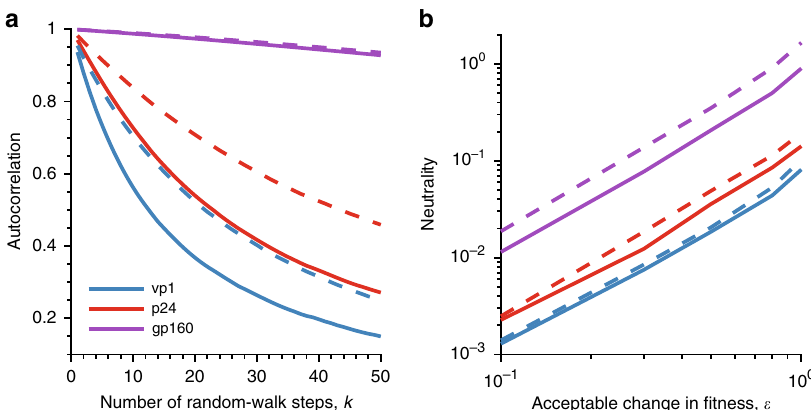
Fig. 7 Comparison of the fi tness landscapes reveals the constrained evolution of vp1 as compared to HIV proteins. a Comparison of the autocorrelation of sequence energies of each protein landscape (see the “ Methods ” section). The x -axis shows the number of random-walk steps ( k ) for which the autocorrelation was computed. Results are shown for two sets of starting sequences, which were selected within a Hamming distance ( D ) of 5 (solid line) and 30 (dashed line) from the MSA (see the “ Methods ” section for detail). Note that the fi tness landscape becomes fl atter for all proteins as we allow the sequences to move further away from the MSA sequences. This is expected, since the sequences that are at a large Hamming distance from the MSA will have relatively lower fi tness due to the low probability of observing those sequences (Supplementary Fig. 11). b Comparison of the neutrality of the landscapes of all three proteins. The neutrality measure quanti fi es the average maximum Hamming distance covered from an initial sequence in a neutral walk, where a random step in the walk is only accepted when the change in fi tness from the sequence at the previous step is within a small value, ϵ (shown on the x -axis). For each protein, neutrality was computed for L = 500 (solid line) and 1000 (dashed line)